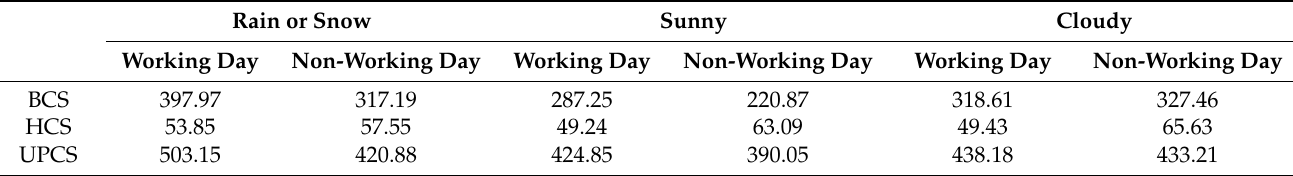
Table 2. Daily average number of charging records under different scenarios.